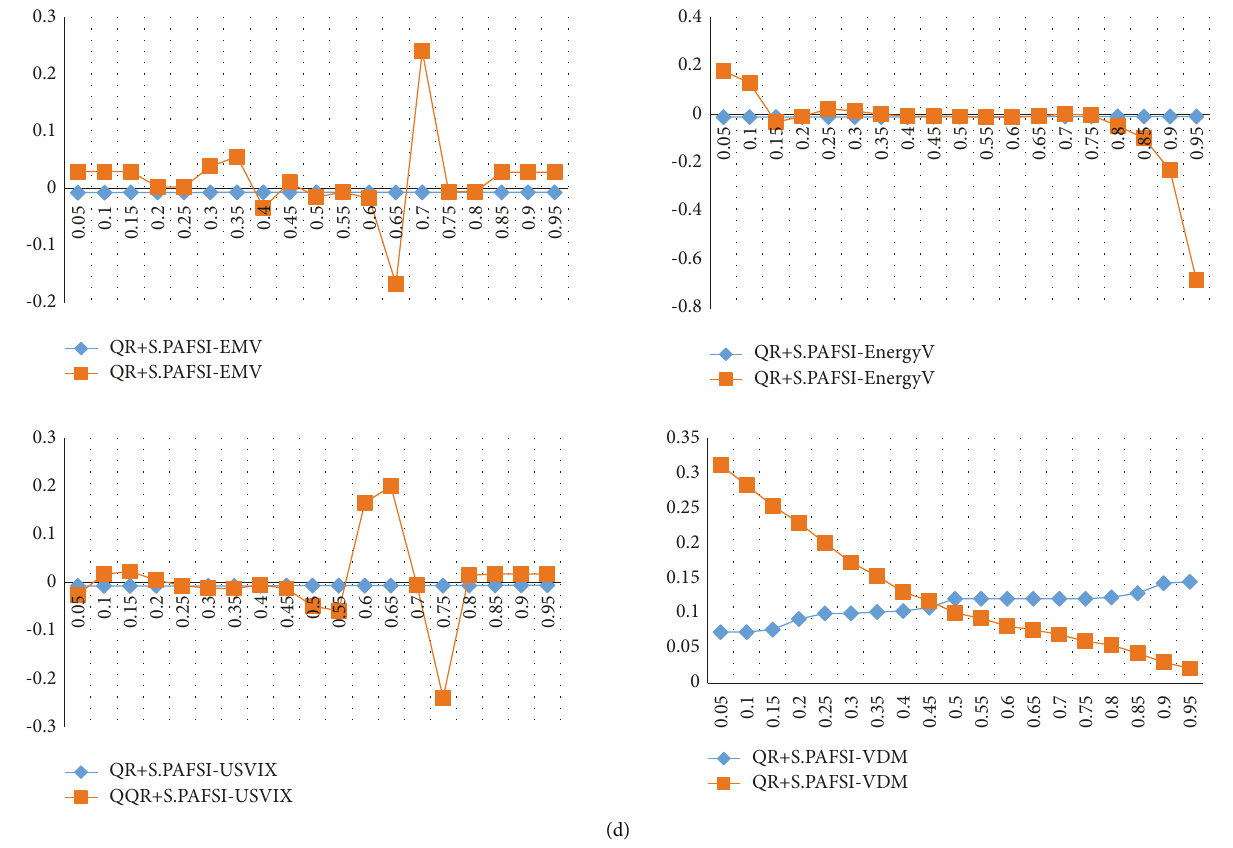
Figure 2: Comparison plots of QR and